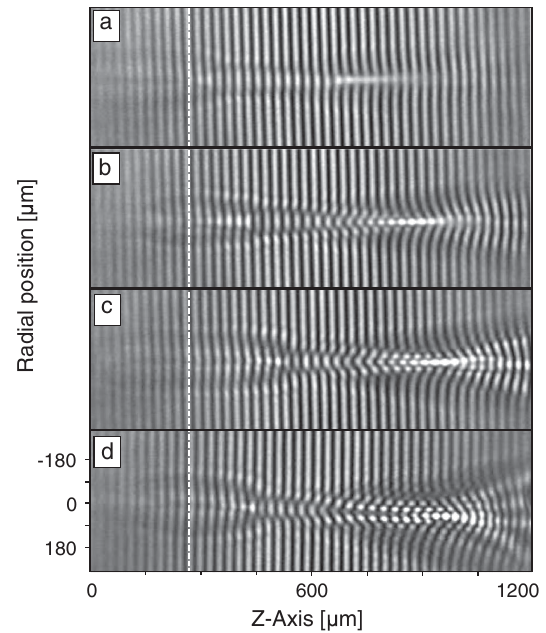
FIG. 5. Interferograms of the plasma channel for the laser power P ¼ 15 GW (the pulse energy of 90 mJ and pulse duration of 6 ps) and 1 : 5 (cid:3) 10 19 cm (cid:4) 3 gas density at different times. Parts (a)–(d) show the interferograms at different delays: